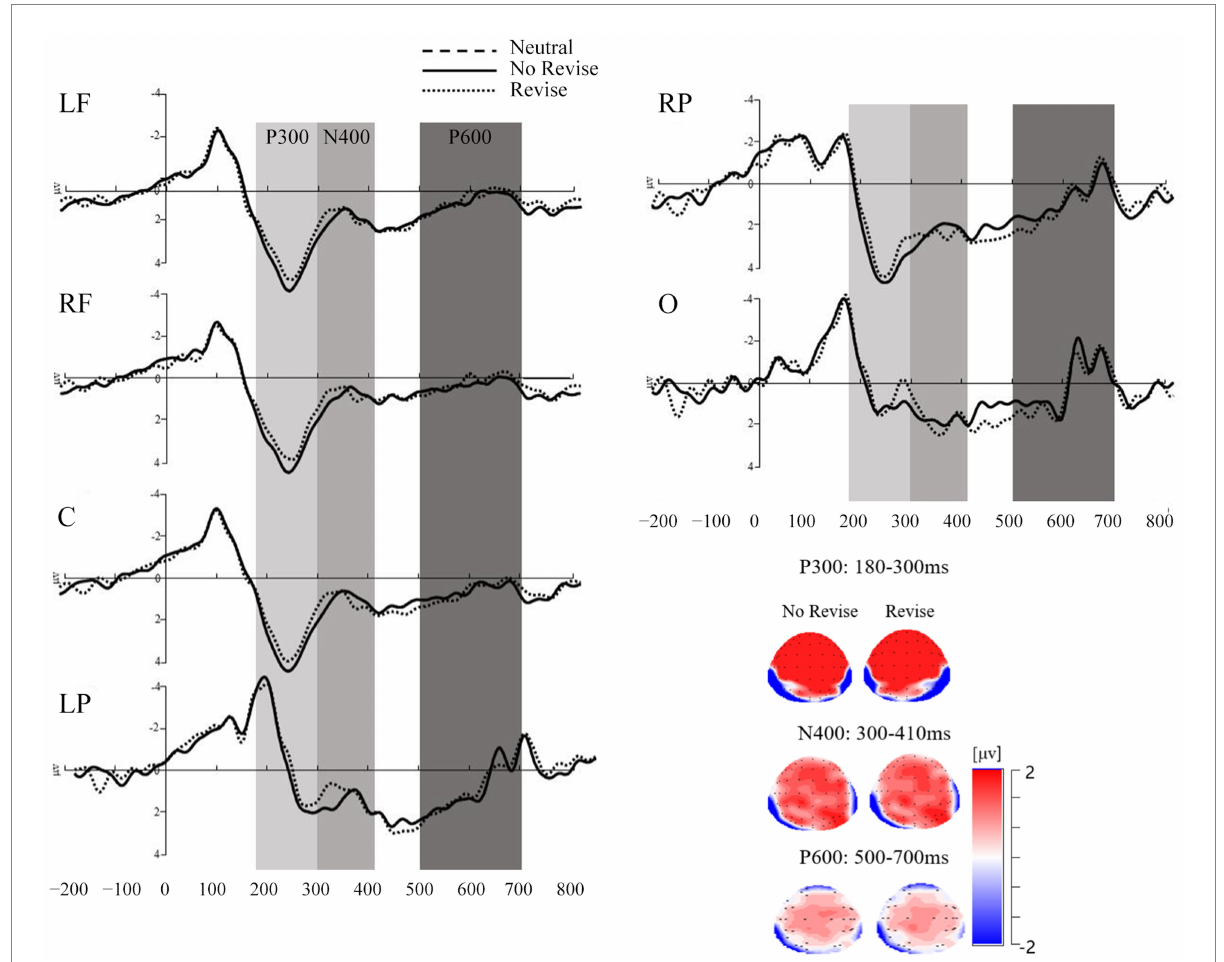
FIGURE 3 Graphical representation of the mean amplitude (in microvolts) for the P300, the N400, and the P600 components divided by contextual conditions and ROIs in Experiment